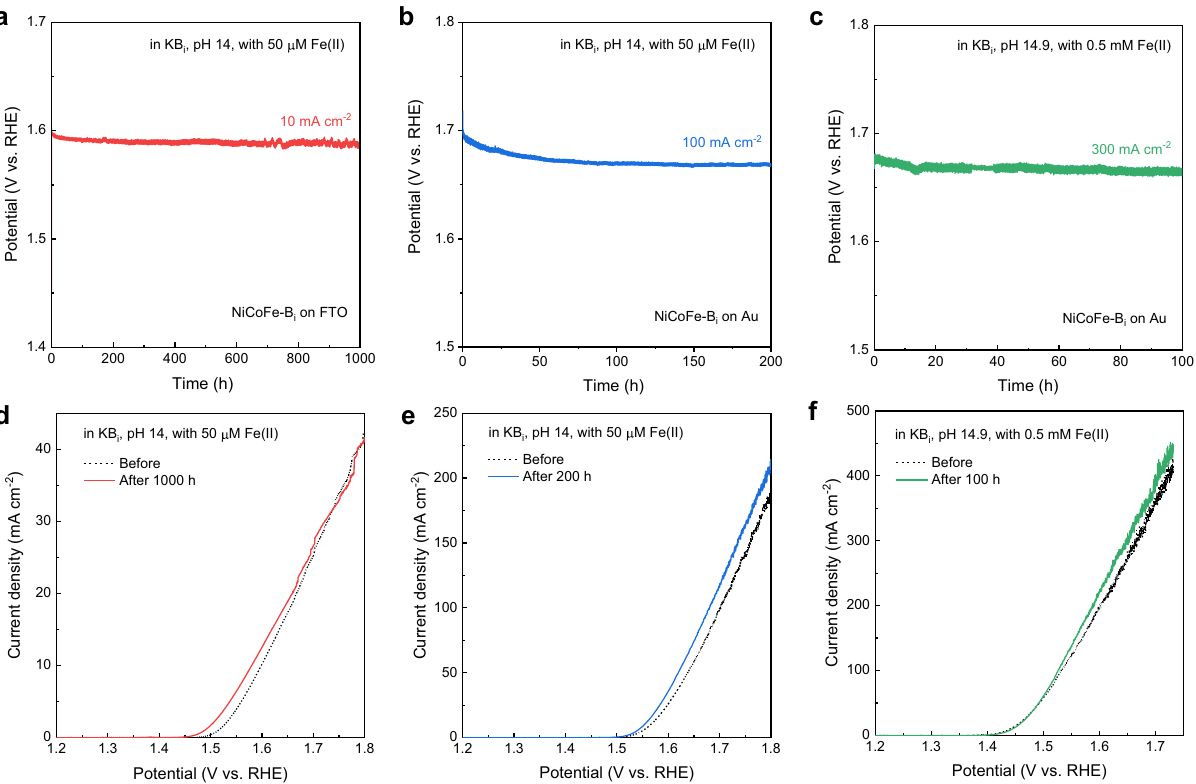
Fig. 4 Self-healing ability of the NiCoFe-B i catalyst under various harsh conditions. Chronopotentiometry tests of the NiCoFe-B i catalysts ( a ) on FTO substrate at 10 mA cm − 2 for 1000 h in KB i electrolyte at pH 14, ( b ) on Au substrate at 100 mA cm − 2 for 200 h in KB i electrolyte at pH 14, and ( c ) on Au substrate at 300 mA cm − 2 for 100 h in KB i electrolyte at pH 14.9. The corresponding polarization curves before and after the stability tests are plotted in ( d – f ). All the polarization curves were measured with 1 mV s − 1 scan rate and all potentials were not corrected for iR